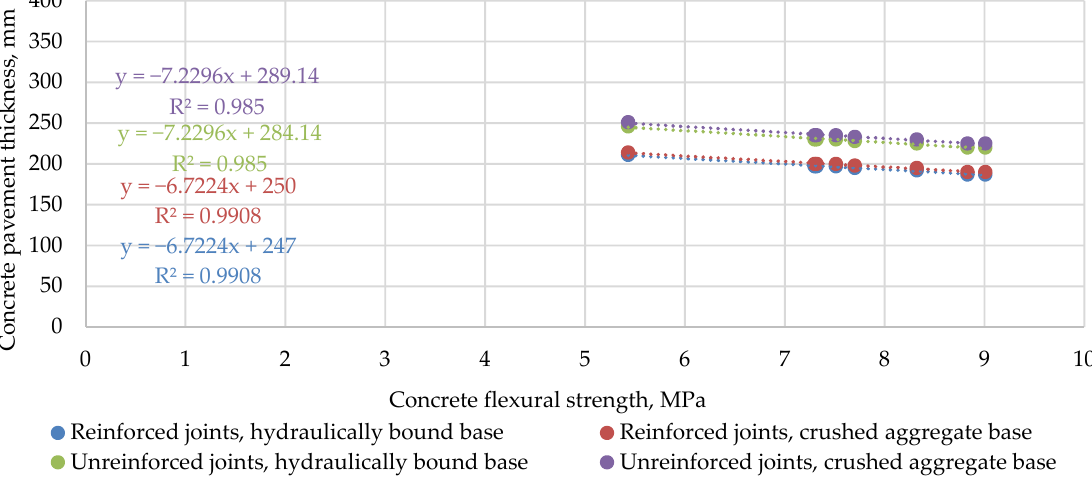
Figure 6. The relationship between the calculated PCP thickness using the software StreetPave and the concrete flexural strength.